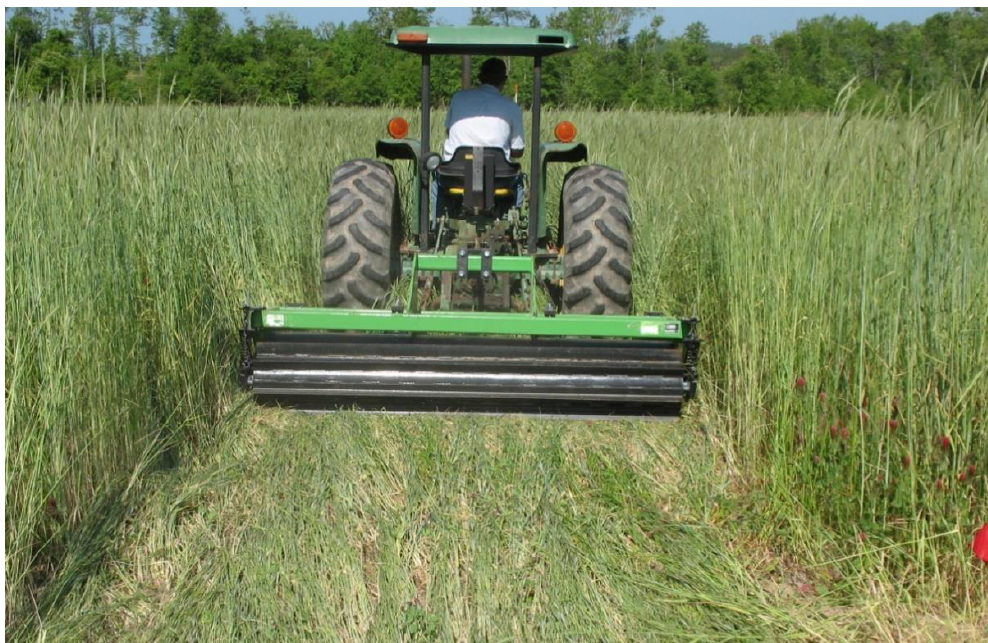
Figure 2. Cereal rye crimson clover mixture being rolled/crimped by an experimental patented 1.8 m wide 2-stage roller/crimper.